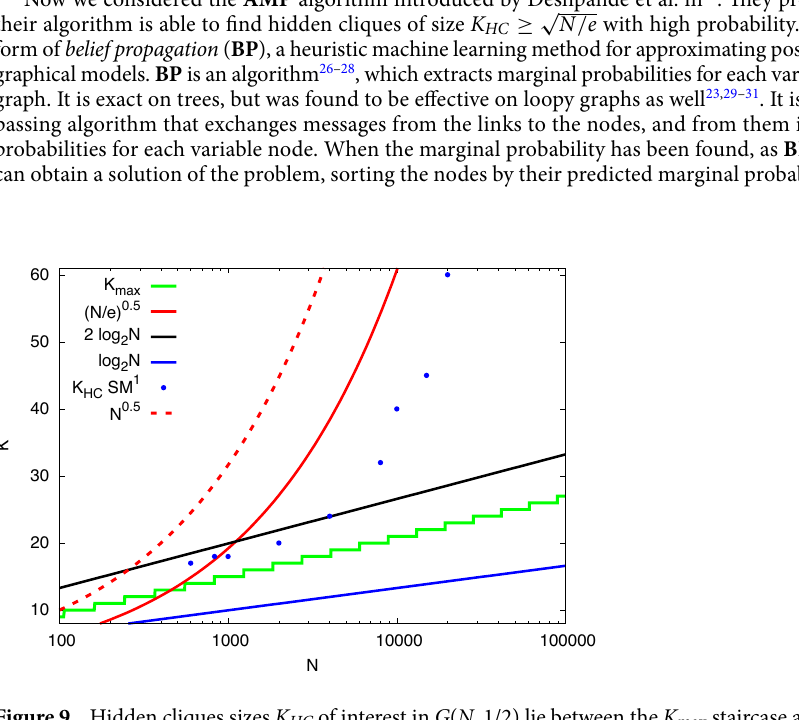
Figure 9. Hidden cliques sizes K HC of interest in G ( N , 1/2) lie between the K max staircase and the proven or experimentally observed lower limits that can be found with spectral methods (dashed red line) or AMP techniques (solid red line). Sizes of the smallest hidden cliques identified with the SM 1 method, augmented by early stopping, are shown with blue dots and lie well below both